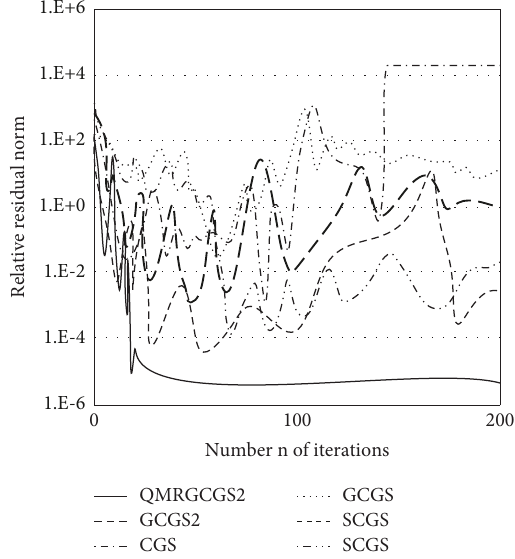
Figure 1: Te relative residual norm of the equation.